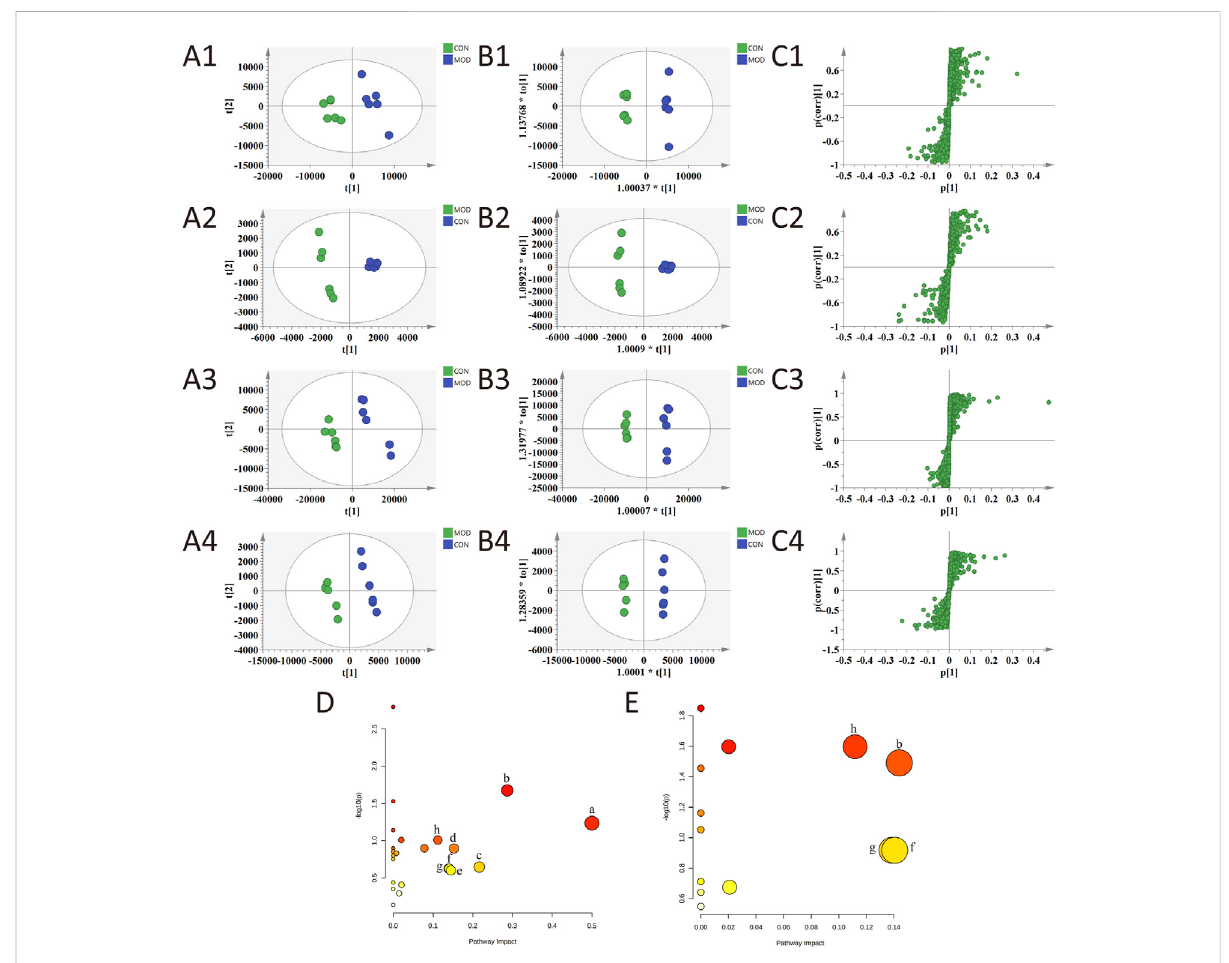
FIGURE 5 PLS-DA (A1 – A4) , OPLS-DA (B1 – B4) and S-plot of OPLS-DA (C1 – C4) for plasma (1, 2) and urine (3, 4) of model group vs. control group in positive(1,3)andnegative(2,4)ionmode;metabolicpathwaysinvolvedinallmarkersinplasmaandurineforT2DM (D) ;metabolicpathwaysinvolved inpotentialmarkersinplasmaand urineregulated byBBP (E) .(a)phenylalanine,tyrosineand tryptophanbiosynthesis;(b)tryptophanmetabolism;(c) retinol metabolism; (d) tyrosine metabolism; (e) purine metabolism; (f) pentose and glucuronate interconversions; (g) starch and sucrose metabolism; (h) glycerophospholipid